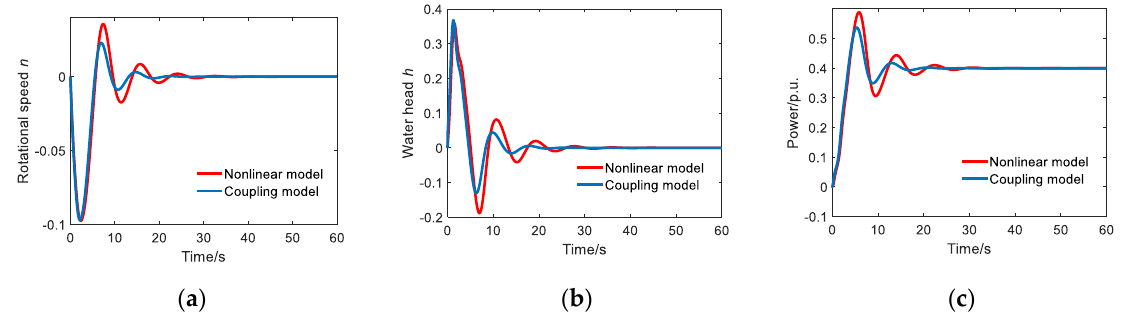
Figure 4. Transient characteristics of two different models during a load increase process; ( a ) time domain diagram of relative deviation of rotation speed n ; ( b ) time domain diagram of relative deviation of water head h ; and ( c ) time domain diagram of relative value of power P t .